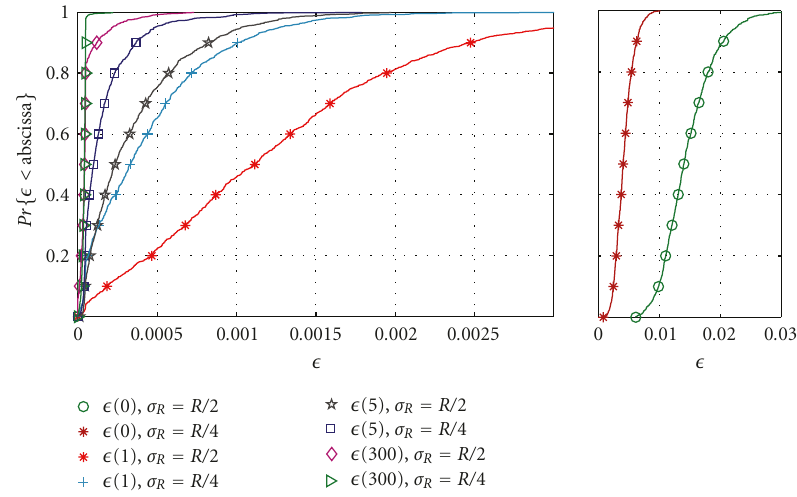
Figure 4: Algorithm convergence, (cid:2) ( i ) = (1 /M )(((1 + Δ (300)) U (300) − U ( i ) ) /U ( i ) ).